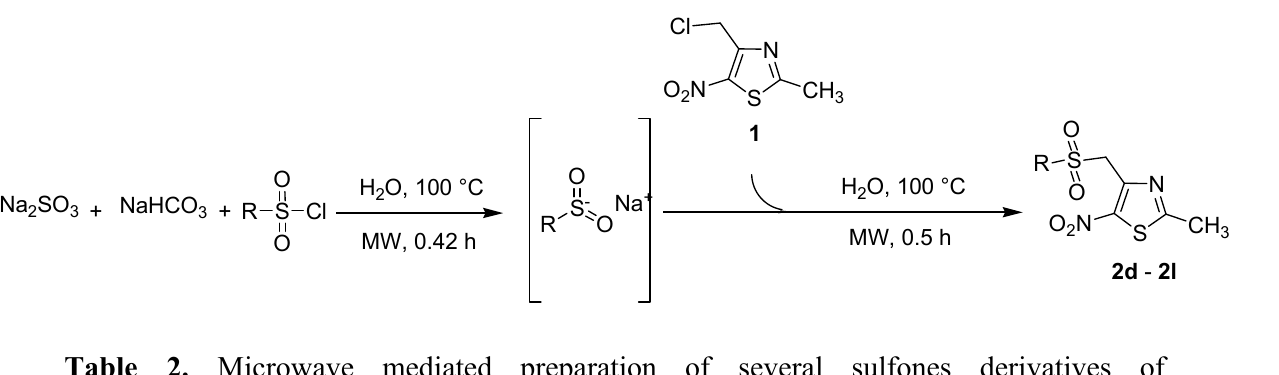
Scheme 3. Preparation of sulfones 2d to 2l .